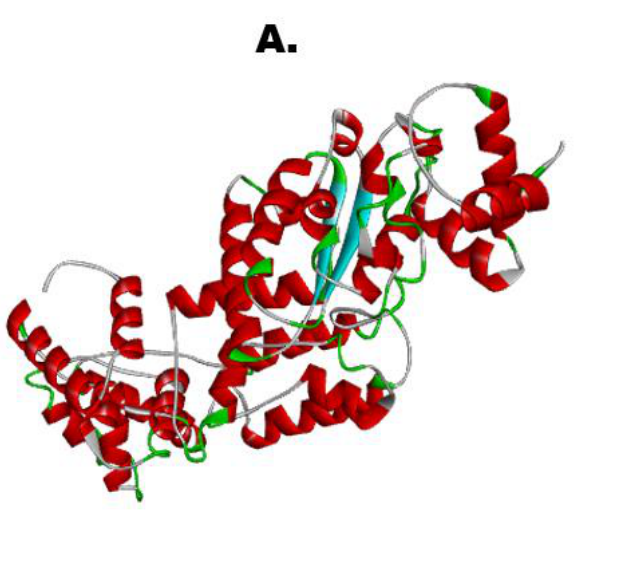
Figure 4. ( A ). 3-D structure of vaccine construct (Tm-Score: 0.205). ( B ). 3-D structure of IKBKE receptor (Tm-Score: 0.401).